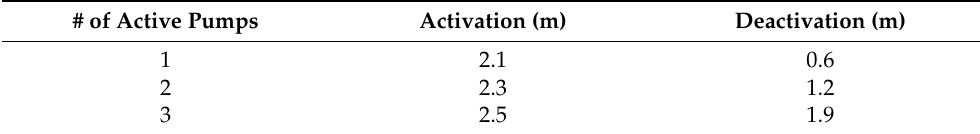
Table 1. Activation and deactivation thresholds.